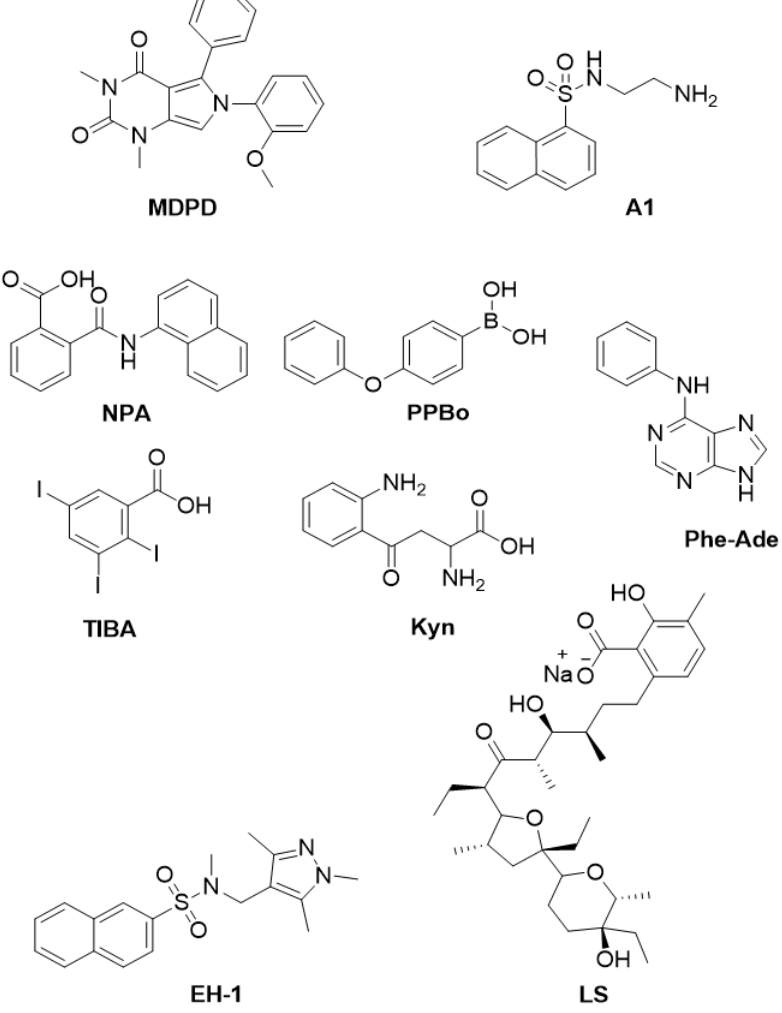
Figure 3. Chemical structures of small molecules affecting plant development. MDPD [32], A1 [38], LS [56], EH-1 [65], Phe-Ade [48], PPBo, NPA, TIBA and Kyn [54]. 4. Small Molecules to Find Out How Plants Cope with Biotic and Abiotic Stresses The world population is predicted to grow to up to 9.6–12.3 billion people by the year 2100 [66]. This in turn will imply a high demand for agricultural products, which should increase by about 50% between 2010 and 2050 [67]. Besides that, the increasing warning from global climate change and the concern about the future survival of crops has prompted researchers both to deepen the study of how plants face abiotic and biotic stress and to develop strategies to improve plant tolerance to abiotic stress as well as plant de- fense from pathogens. As for the latter, recently, two noteworthy studies based on a chem- ical genetic strategy have been published; the first identified three components of the methylosome as negative regulators of disease resistance [68], while the other isolated small molecules to inhibit the FERONIA RLKs (receptor-like kinases), which negatively regulate root immunity and plant response to soil-borne diseases [69]. To investigate how the cytosolic NLRs (Nucleotide-binding leucine-rich repeat) immune receptors elicit the ETI (effector-triggered immunity), Huang et al. [68] performed an HTS (13,600 commer- cially available compounds) aimed at identifying small molecules able to suppress the autoimmune phenotype of the gain-of-function chs3-2D ( chilling sensitive 3, 2D ) mutant [68,70]. It was identified that one compound, Ro 8-4304, (4-[3-[4-(4-fluorophenyl)-1,2,3,6- tetrahydro-1(2 H )-pyridinyl]-2-hydroxypropoxy] benzamide hydrochloride) (Figure 4),